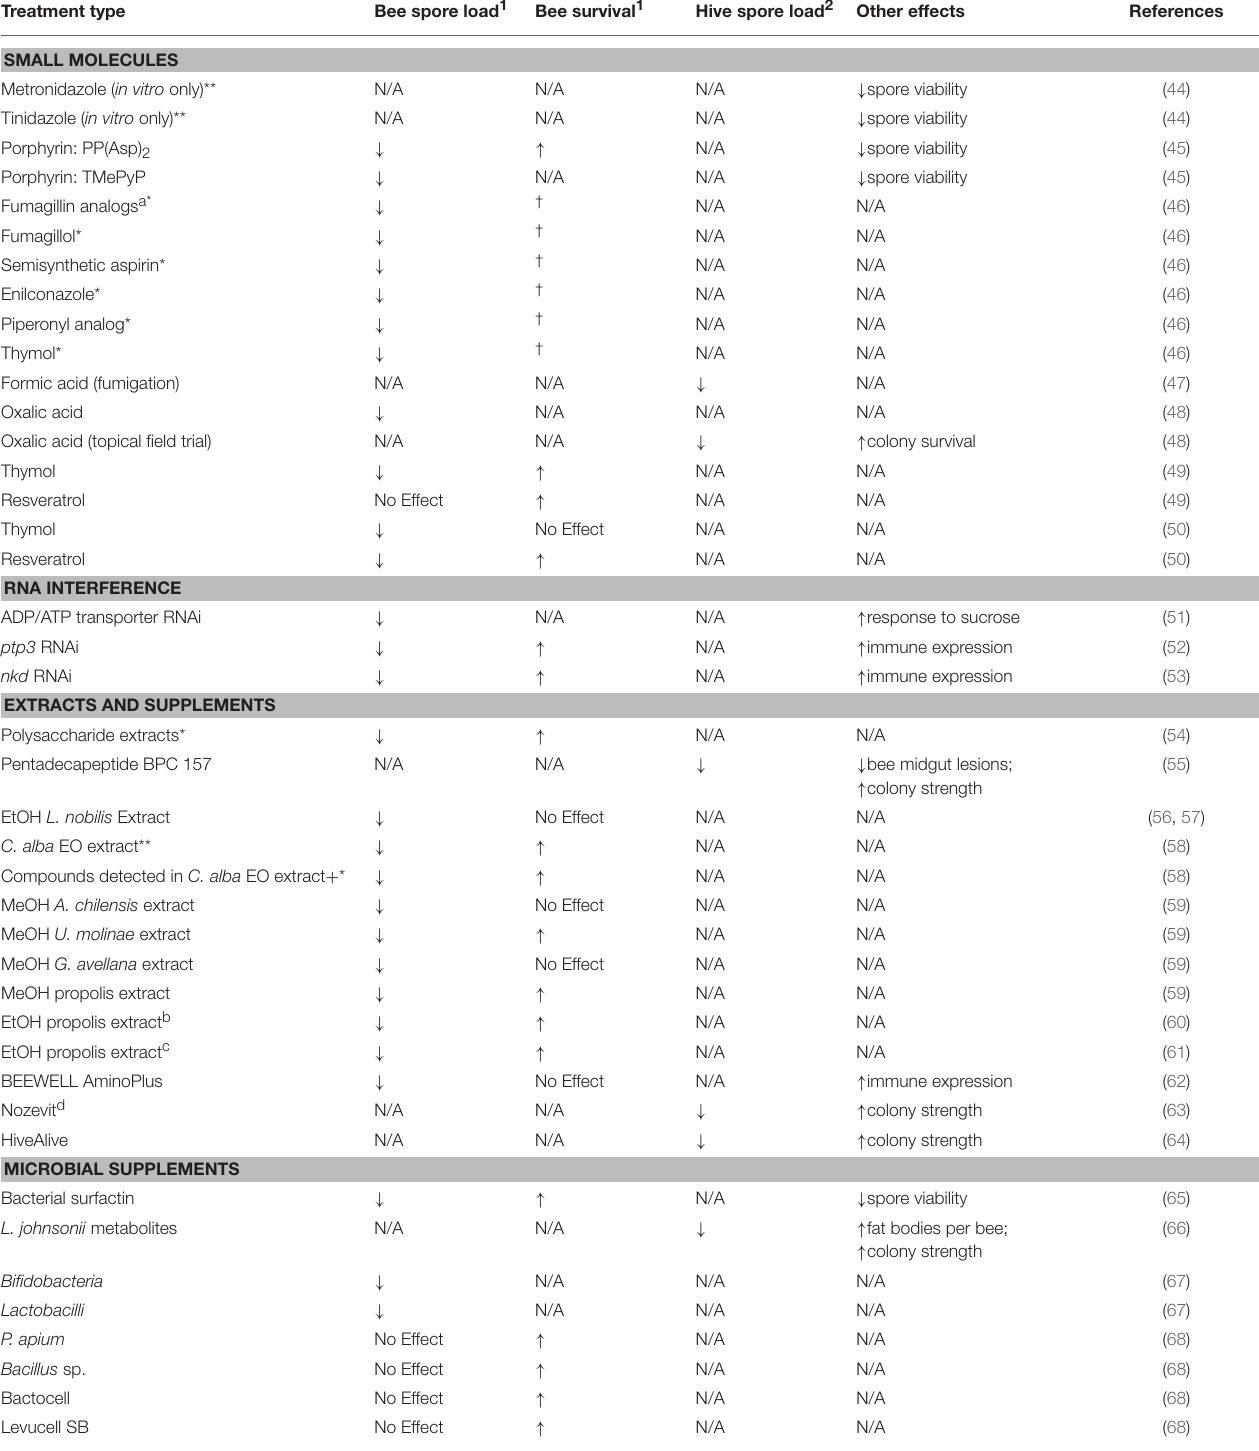
TABLE 1 | A summary and comparison of anti- N. ceranae treatments that have displayed efficacy in previous works. Treatment